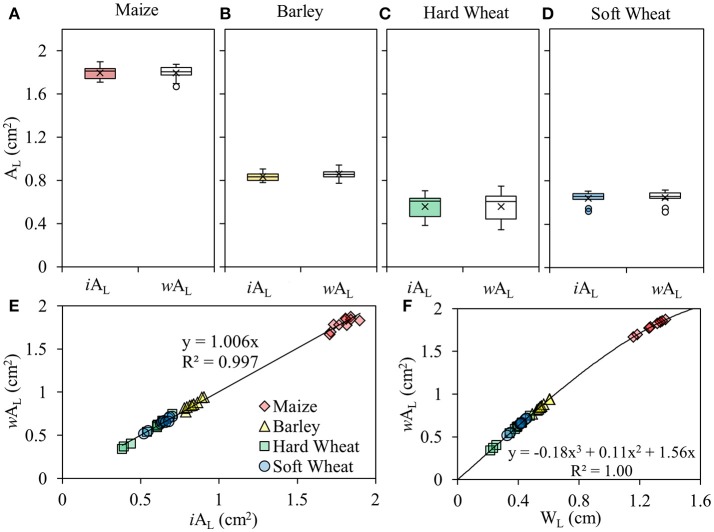
Box plots of the leaf area included in the leaf gasket during photosynthesis measurements (AL) measured using an image-based approach (iAL) and estimated using a leaf width–based approach (wAL) of maize (A), barley (B), hard wheat (C) and soft wheat leaves (D) (P < 0.05; n = 10). The lower and upper part of the boxes give the estimated 25 and 75th percentile, the horizontal line through the box indicates the median value, the x markers indicate the mean of the sample, the top of upper whisker indicates the maximum value of the sample and the bottom of the lower whisker indicates the minimum of the sample; the linear relation between the wAL and iAL
(E); the curvilinear relation between the WL and wAL
(F).